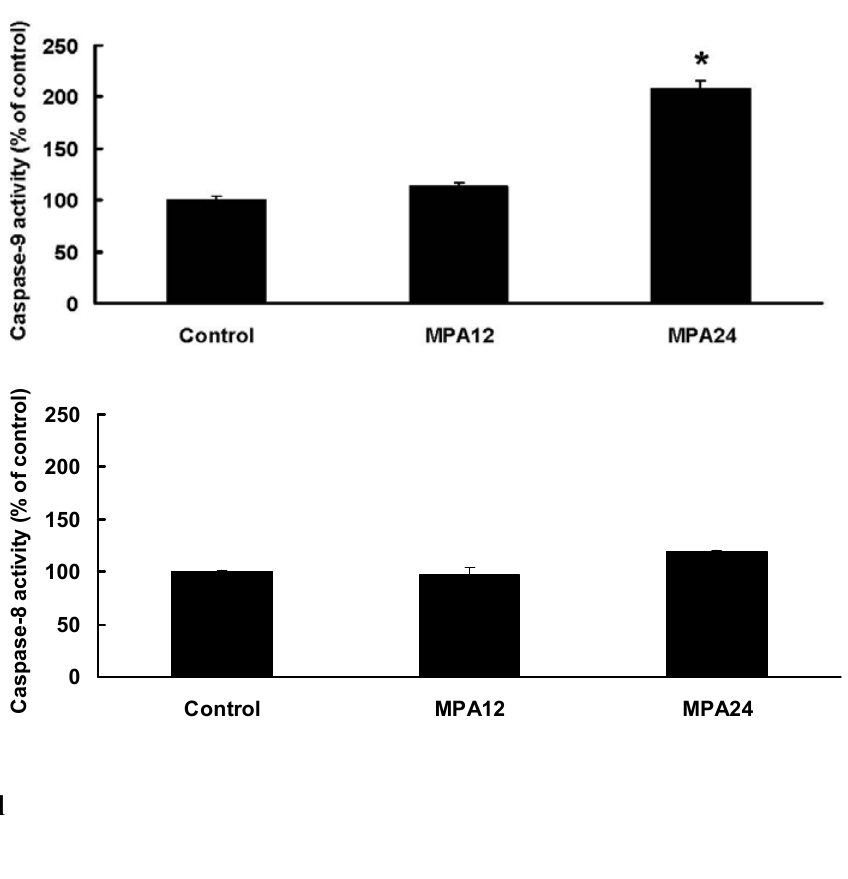
Figure 6. The effects of MPA on caspase-9 and -8 activities. MCF-7 cells were treated with 50  M of test agents for 12 or 24 h. From the left side were: control; MPA, 12 h; MPA, 24 h. Data were expressed as means ± SD ( n = 3). * Significantly different ( p < 0.01) versus the control (without any